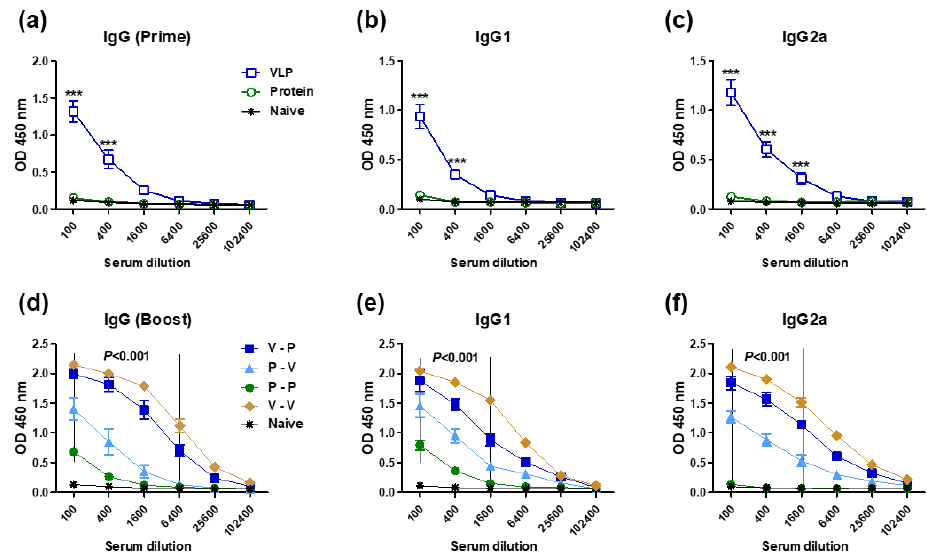
Figure 1. VLP is superior to protein in priming M2e specific IgG and IgG2a isotype antibodies.